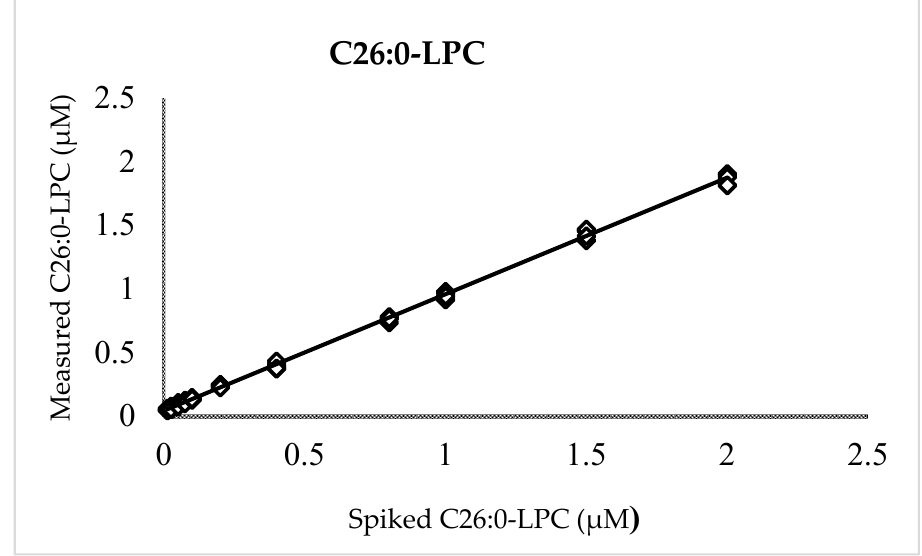
Figure 1. C26:0 ‐ LPC linearity. Measured vs. enriched concentrations of C26:0 ‐ LPC in quintuplicates Figure 1. C26:0-LPC linearity. Measured vs. enriched concentrations of C26:0-LPC in quintuplicates at 0.0125, 0.025, 0.05, 0.075, 0.1, 0.2, 0.4, 0.8, 1.0, 1.5, and 2.0 μ M. at 0.0125, 0.025, 0.05, 0.075, 0.1, 0.2, 0.4, 0.8, 1.0, 1.5, and 2.0 µ For accuracy and precision, 25 DBSs at each level of 0.1, 0.25, 0.5, 1.0, and 2.0 μ M